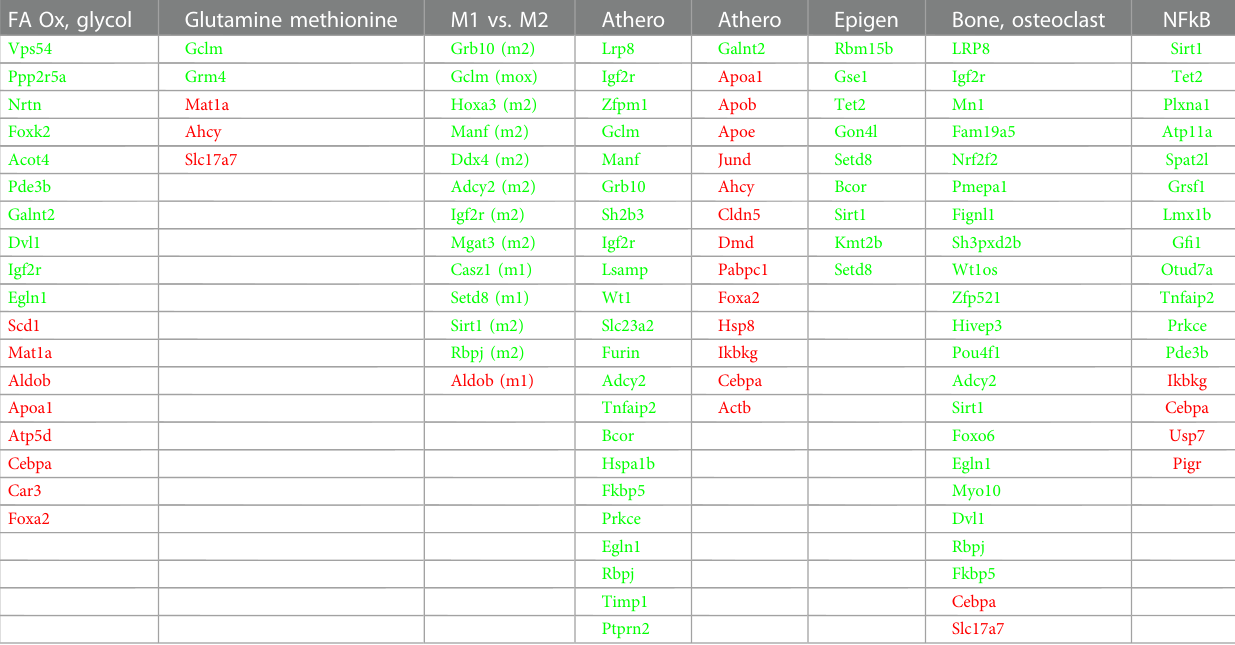
TABLE 1 DMRs that were statistically different in mice that received BM from Pg -inoculated donors relative to sham-treated. FA Ox, glycol